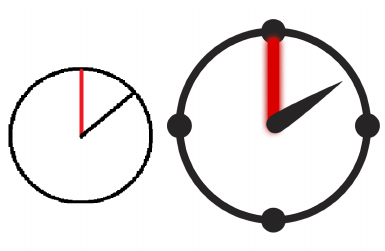
This figure shows an example of the clocks used in GNomon for selecting game objects (right) and the original NOMON clock (left). The appearance of the new GNomon clock is based on the original design but with important modifications suggested by the experts: enlarging the clock, thickening all clock lines, placing marks at clock quarters, rendering more eye-catching the red noon hand and making the moving clock hand